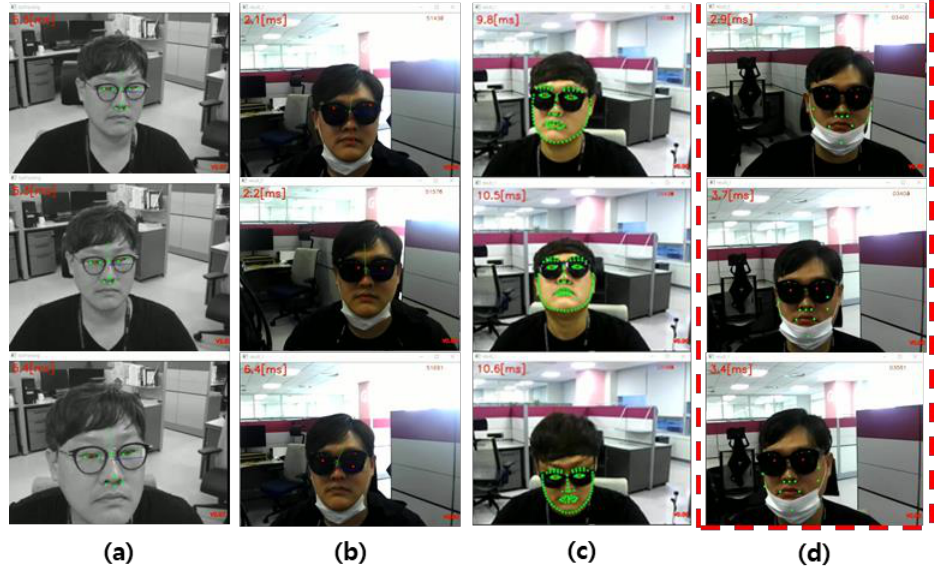
Figure 7. Method comparison. ( a ) Direct eye tracking for bare faces using the SDM+SIFT algorithm [23]. It showed 2 mm precision with 10% CPU consumption at a speed of 2–5 ms per frame. ( b ) Direct eye tracking for sunglasses-wearing faces using the SDM+SIFT algorithm [23]. It showed 25 mm precision with 10% CPU consumption at a speed of 2–5 ms per frame ( c ) Direct eye tracking using a CNN-based PFLD algorithm [36]. It showed 8 mm precision with 25% CPU consumption at a speed of 12 ms per frame. ( d ) Proposed indirect pupil position estimation method, which includes an indirect eye-tracking algorithm that estimates pupil location based on other facial feature points. The proposed method showed 10 mm precision with 10% CPU consumption at a speed of 2–5 ms per frame.